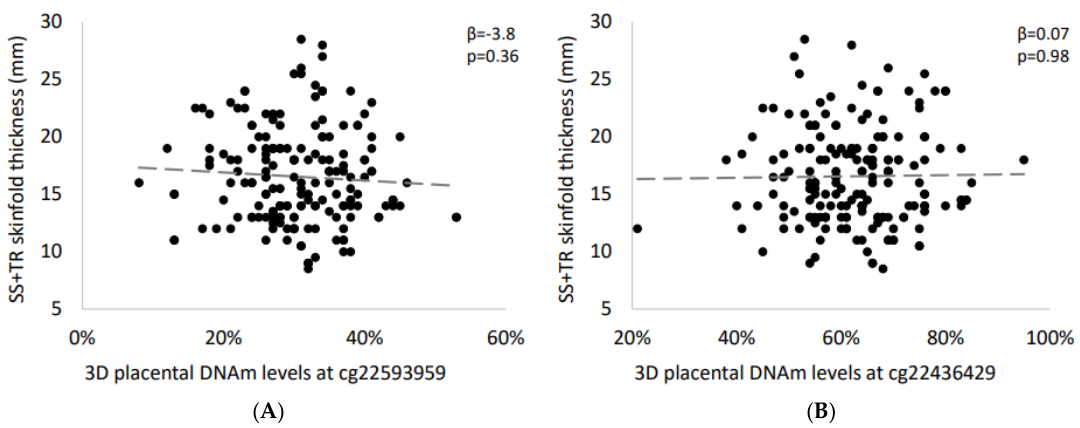
Figure 4. Association between placental DNAm levels at significant CpG sites and early-childhood adiposity in the independent 3D birth cohort. Spearman’s correlation tests were used to assess the association between skinfold thickness and DNAm levels at ( A ) cg22593959 and ( B ) cg22436429.